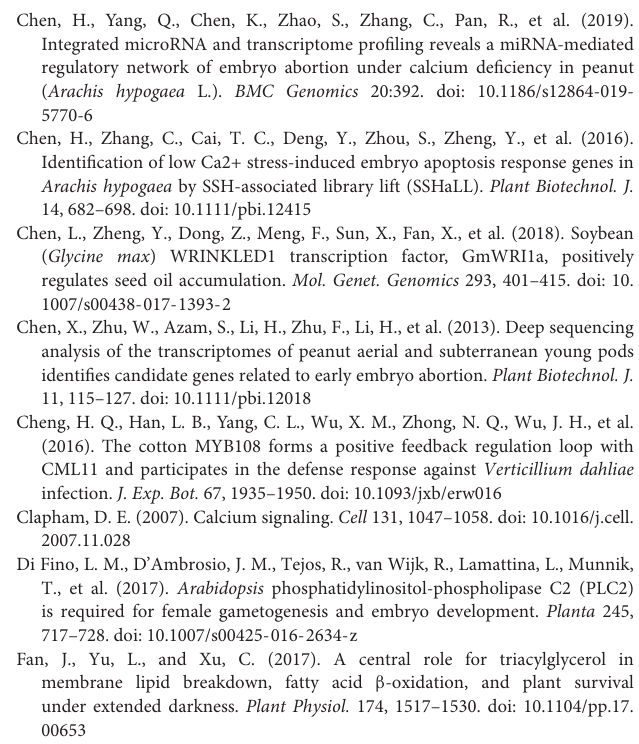
Supplementary Figure 1 | The percentage of mapped reads distribution in different sites (intro, intergenic and exon) of gene in peanut embryos under calcium deficiency and sufficiency conditions. The X axis represented three repetitions of peanut embryos under calcium deficiency and sufficiency conditions at 15, 20, and 30 DAP, respectively. The Y axis is represented the percentage of mapped reads distributed in different sites of gene. Blue column: exon; Orange: intergenic; Gray: intron. Three biological replicates were carried out for each